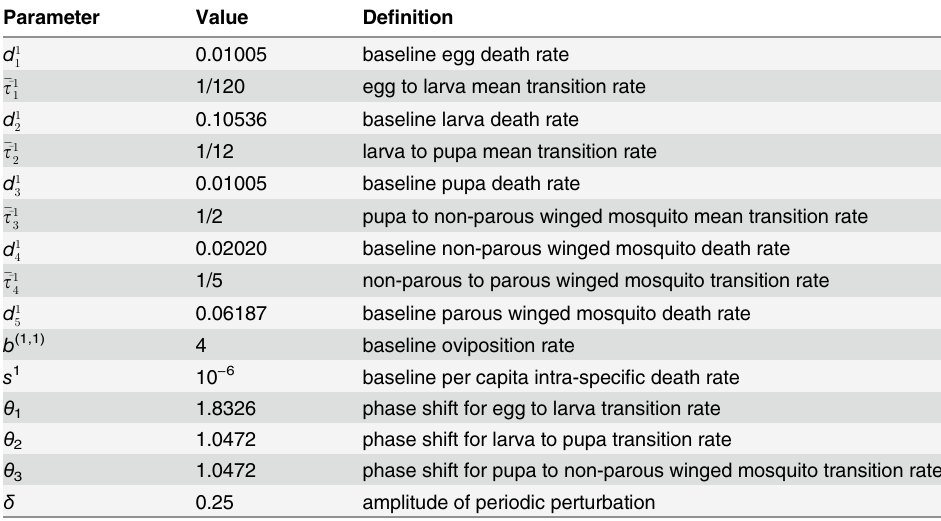
Transition, death, oviposition rates, amplitude of periodic perturbation and phase shifts for susceptible individuals in the model depicted in Fig 1. Rates are given in day − 1 , the s 1 parameter is given in day − 1 (cid:3) individual − 1 whilst phase shifts are presented in radians. The parameter δ is